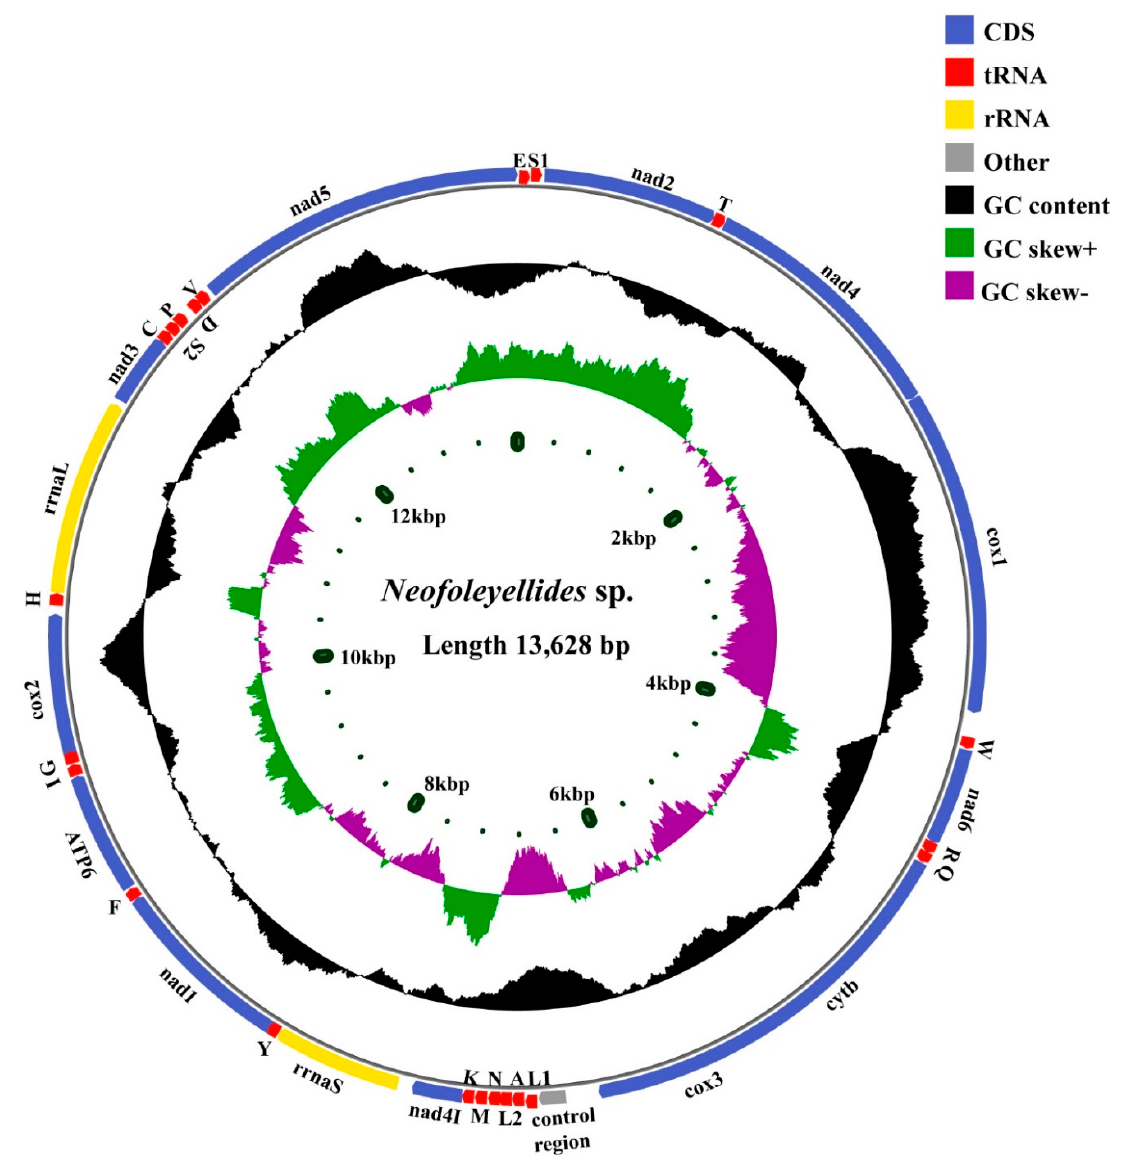
Figure 1. Structural representation of Neofoleyellides sp. mitogenome. From inside to outside, the first circle represents the length scale, the second circle represents the GC skew, the third circle represents the GC content, and the fourth circle represents the arrangement of PCGs, tRNAs, and rRNAs; each tRNA is identified by a unique letter abbreviation. Table 1. Mitochondrial genome organization of Neofoleyellides sp .